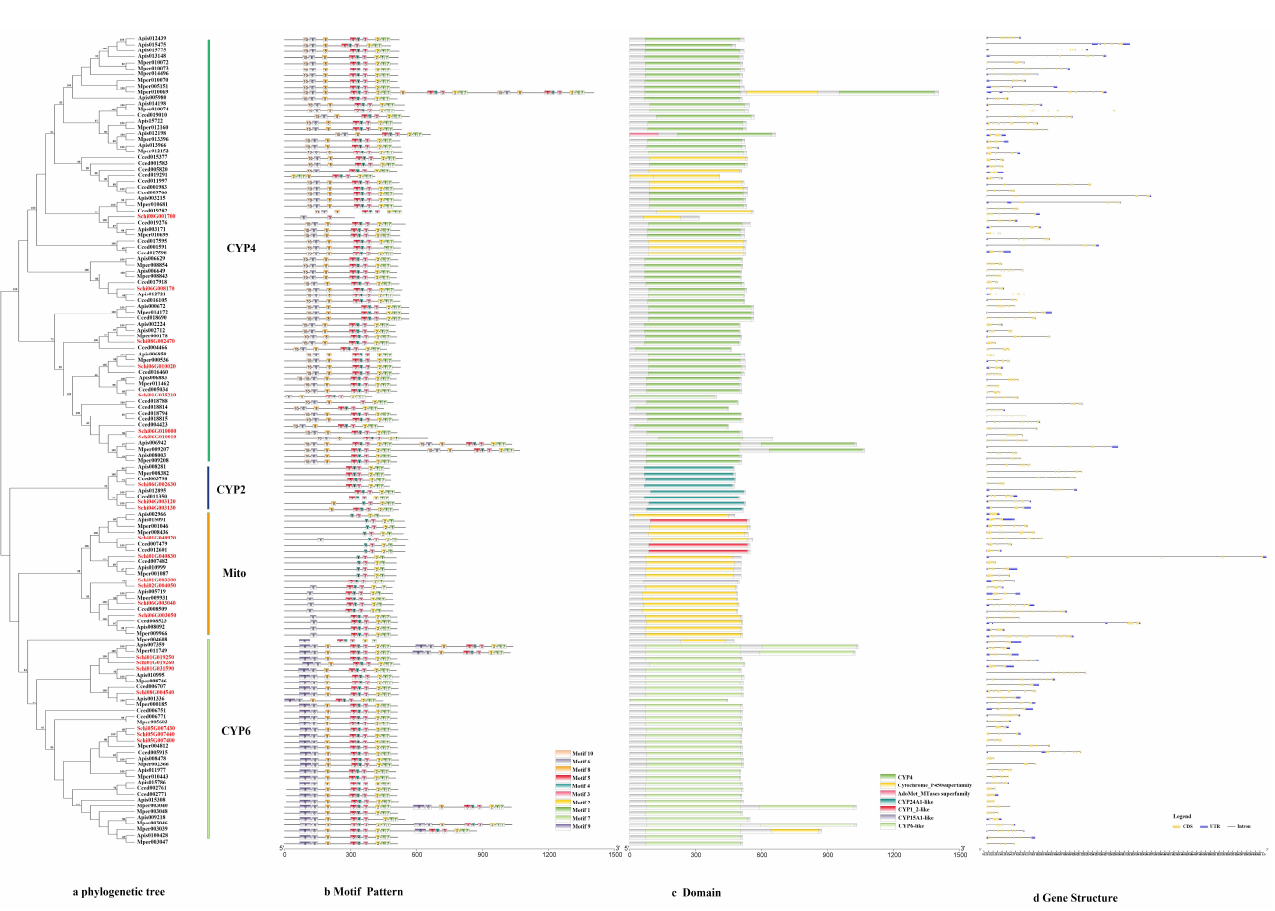
Figure 1. ( a ) Phylogenetic relationships, ( b ) conserved motifs, ( c ) domains and ( d ) gene structure analysis of detoxification genes of the P450 gene family in S. chinensis , A. pisum , C. cedri , and M. persicae .